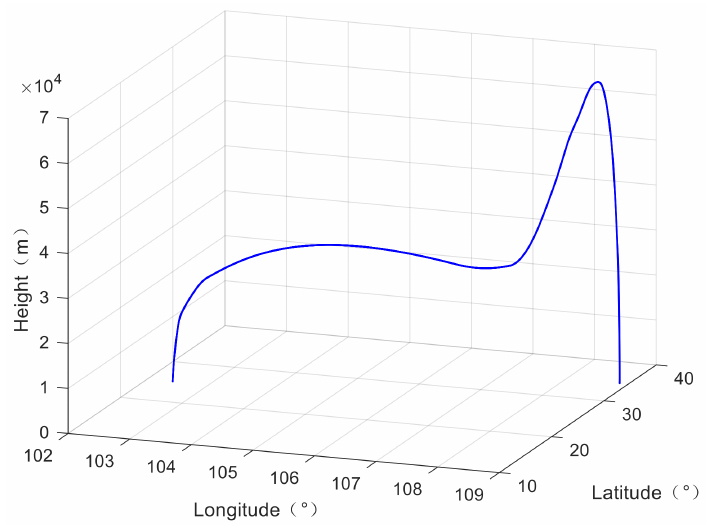
Figure 4. 3D trajectory of a hypersonic boost-glide